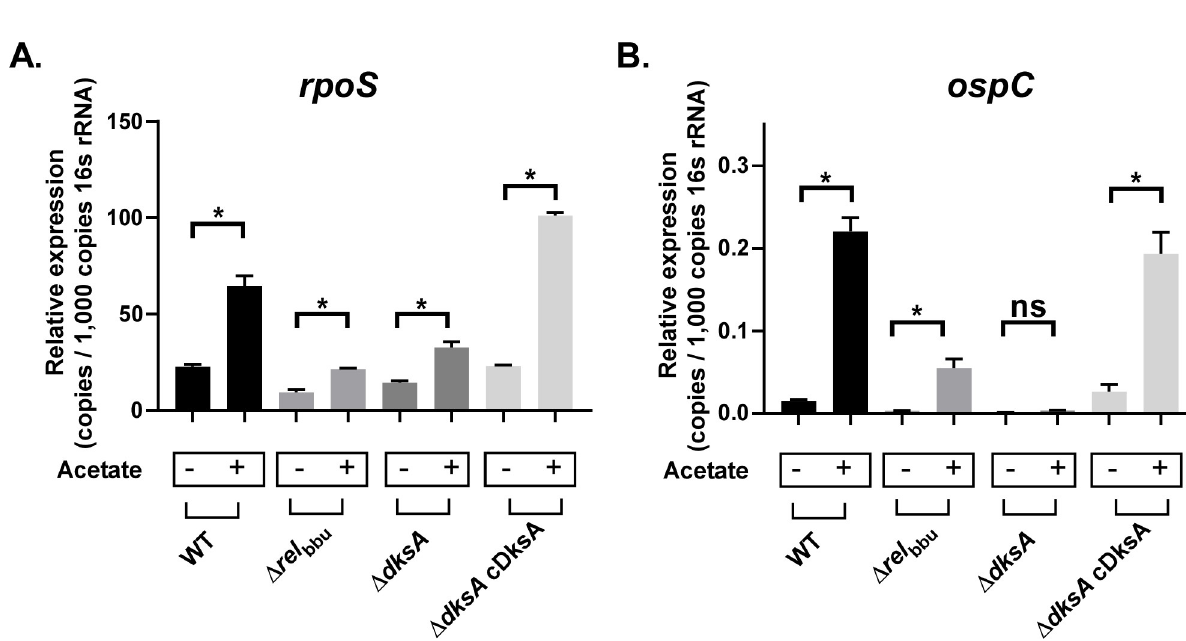
Fig 5. RT-qPCR analysis of rpoS and ospC transcripts in wild-type (WT), Δ rel bbu , Δ dksA , and Δ dksA cDksA (cDksA) strains. RT-qPCR was performed on RNA extracted from wild-type (WT), Δ rel bbu , and Δ dksA mid-logarithmic phase cultures in BSKII 7.6 (acetate -) or BSKII 6.7 + 20 mM acetate (acetate +). Relative expression of rpoS (A)and ospC (B) were normalized to 16s rRNA. Error bars represent standard deviation calculated from three biological replicates. Asterisk indicates p -value < 0.05 for relative expression between BSKII 7.6 and BSKII 6.7 + 20 mM acetate conditions in a Sidak multiple comparisons